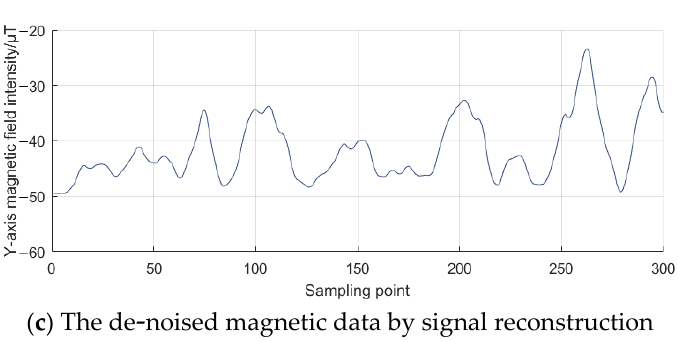
Figure 5. The preprocessing of raw measuring magnetic data.